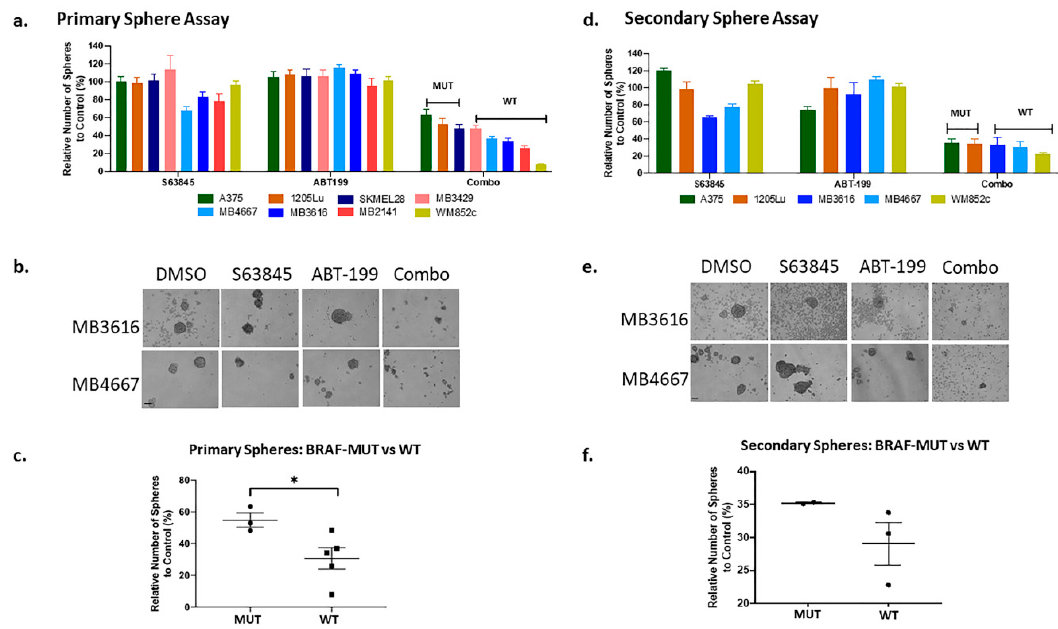
Figure 4. The combination of ABT-199 with S63845 significantly inhibited sphere-forming capacity of the Melanoma Initiating Cells. Melanoma cells were subjected to the primary sphere assay ( a – c ). Spheres were treated with the indicated compounds either alone, or in combination, for 48 h, and the number of surviving spheres were counted and quantified ( a ). ( b ) Shows example images by phase contrast microscopy. ( c ) Dot plot of normalized primary sphere (expressed as percentage) for combination treatment in BRAF-V600E MUT and WT lines. Secondary sphere assay was conducted with surviving cells from each treatment conditions from the primary sphere assay ( d – f ). ( d ) Quantification of the number of secondary spheres; ( e ) the images of a representative secondary sphere, and ( f ) dot plot of the relative number of secondary spheres in the combination wells for BRAF-V600E MUT and WT lines. In all melanoma lines, the combination treatment significantly reduced the primary and secondary sphere formation compared with all other treatments (DMSO or single drug). For visual clarity, we have not marked the significance in panel ( a ) and ( d ). * indicates p < 0.05. Error bars represent +/ − SEM. For clarity and readability of panels a and b, we listed p values in Table S5. Scale bar = 100 µ